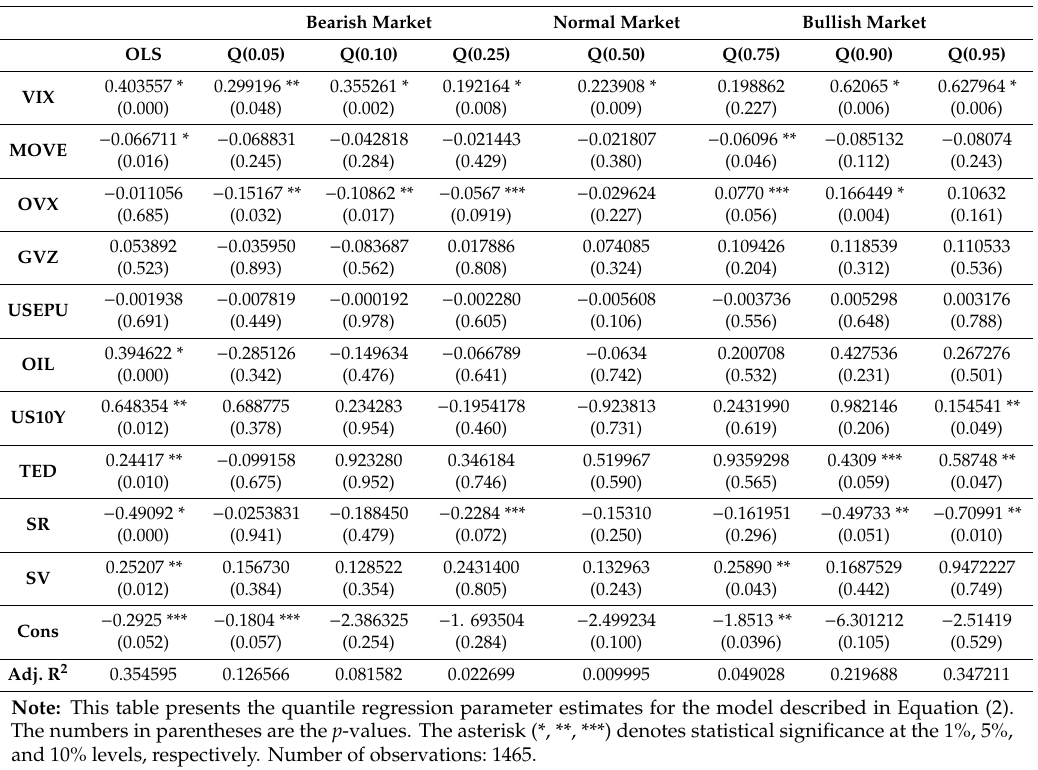
Table 3. Quantile regression estimates for the UAE.